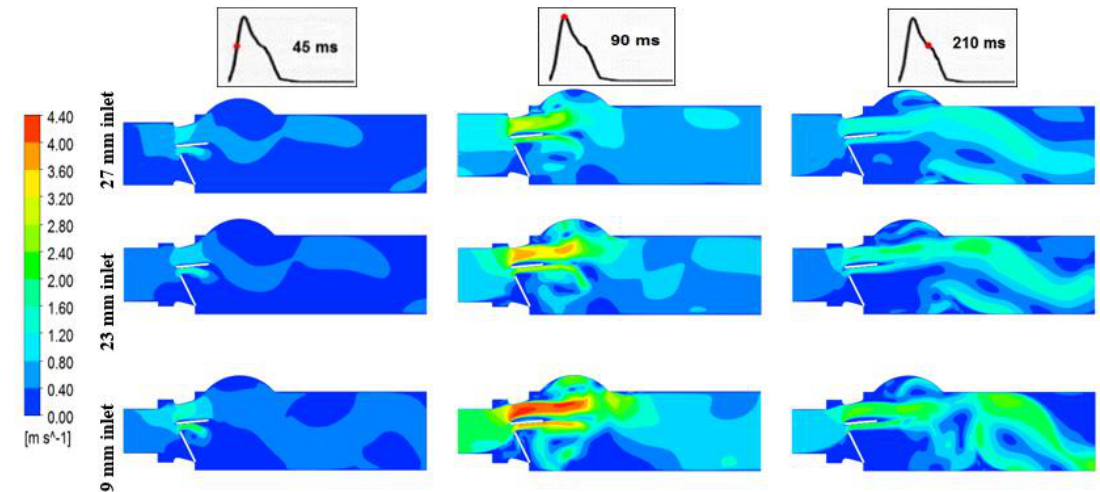
Figure 4. Velocity contours for three LVOT diameters (27, 23 and 19 m) at three different time instants (45 (acceleration phase), 90 ms (peak) and 210 ms (deceleration phase)) during the systole for 100% dysfunctional BMHV at the normal cardiac output (5 L/min).